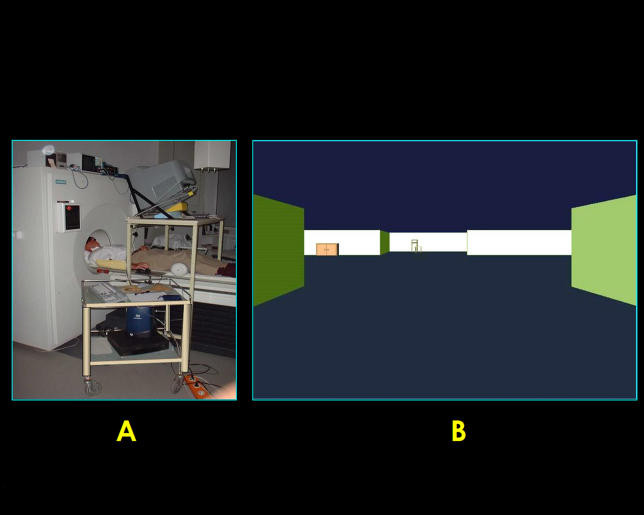
Experimental Setup(A) Experimental setup, showing a participant in the PET scanner during performance of a navigation task in the VR environment.(B) Snapshot of the visual impression of the test condition in the virtual environment at the start point of the navigation task.